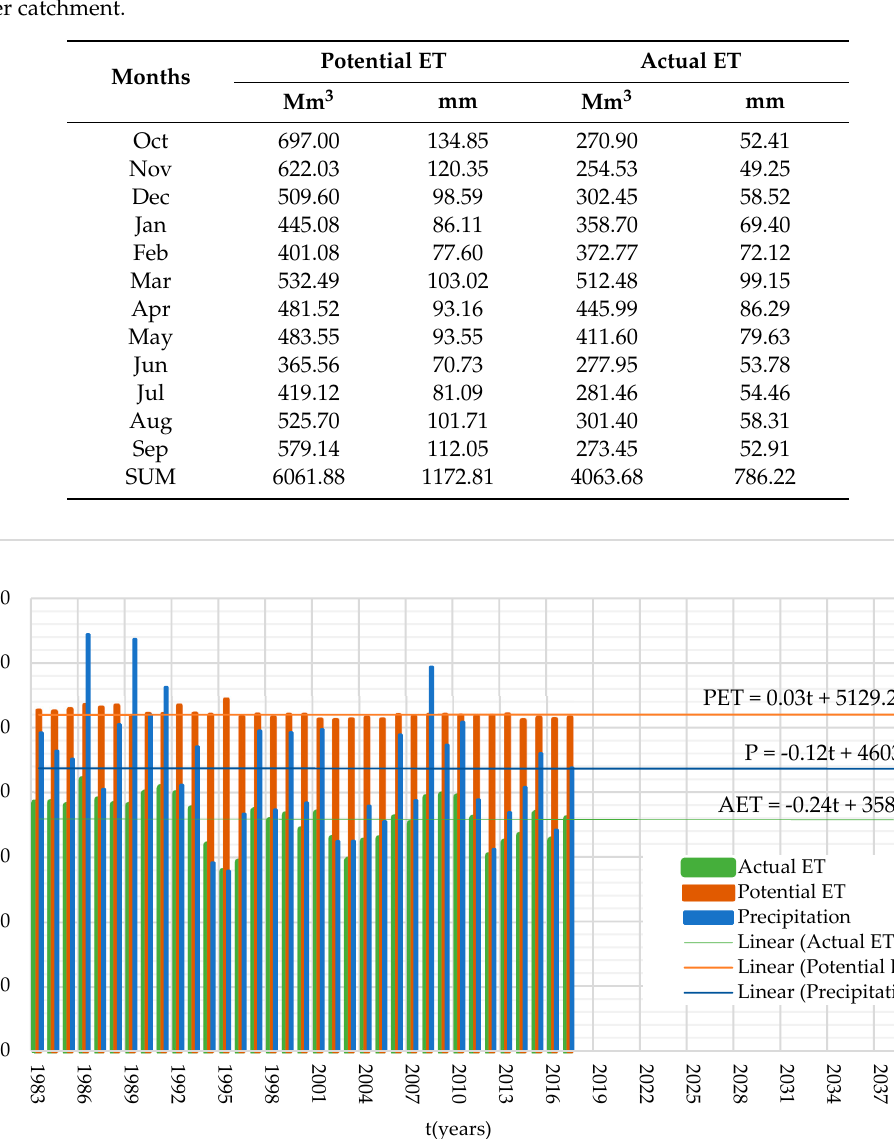
Table 5. WEAP simulated mean monthly potential and actual evapotranspiration for Chongwe River catchment.